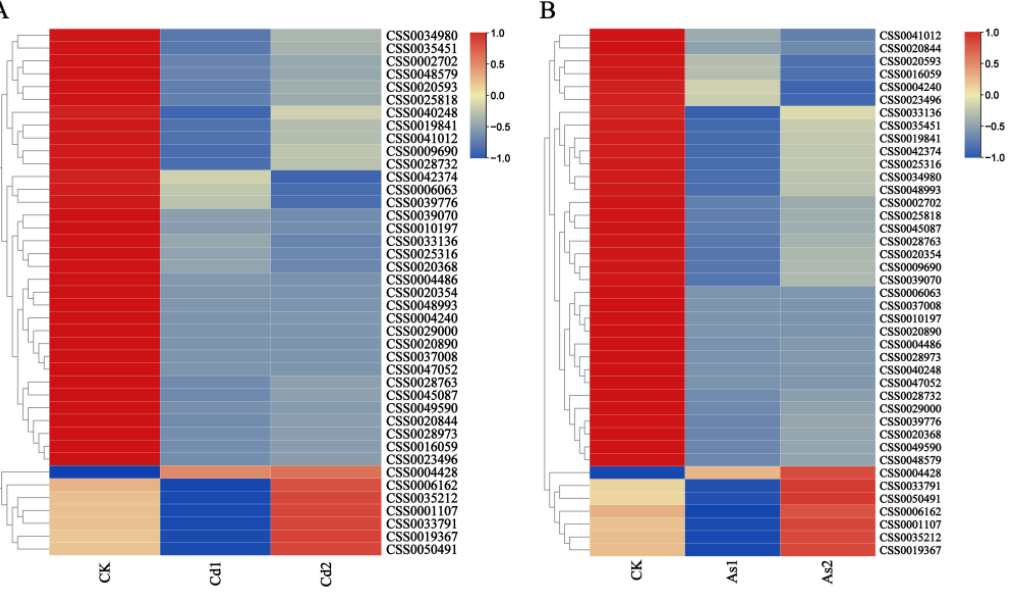
Figure 6. Expression patterns of DEGs in tea roots under Cd and As stresses. ( A ) Expression patterns of DEGs in tea roots under Cd stresses; ( B ) Expression patterns of DEGs in tea roots under As stresses. The scale bars represent the log 2 transformations of the FPKM values. The colors from red to blue indicated the highest to lowest log 2 (FPKM) values of each gene under the heavy metals Cd and As treatments.